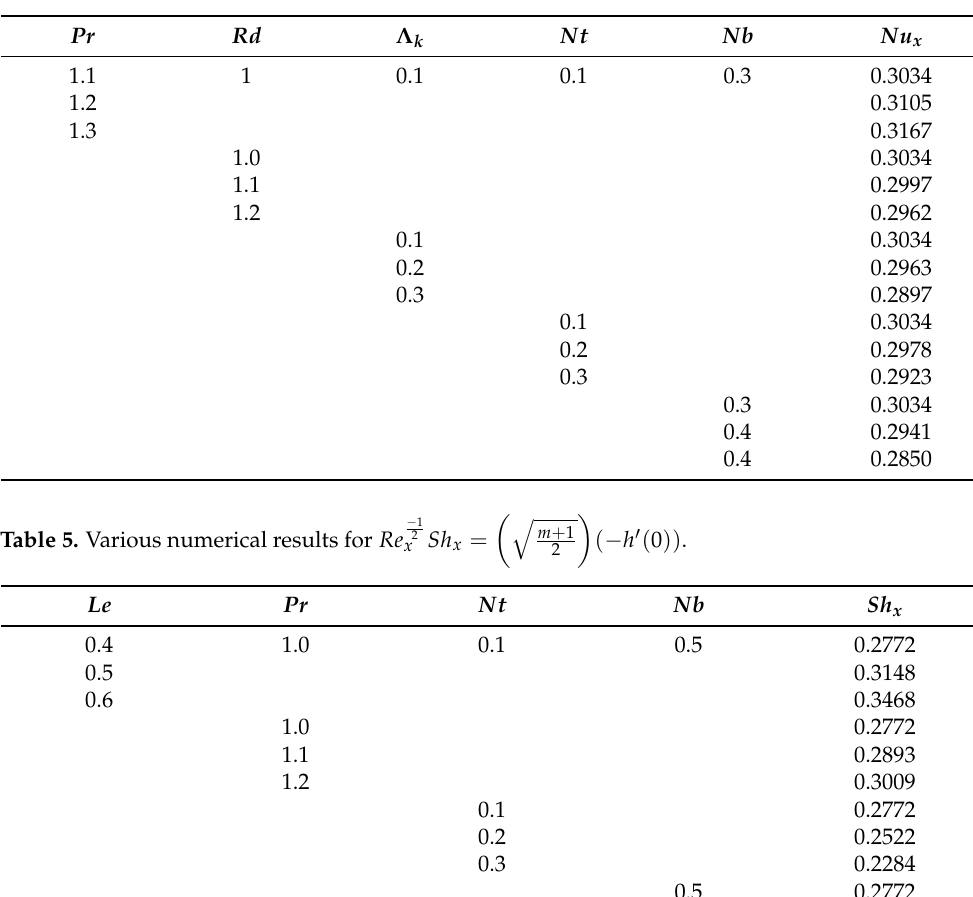
(cid:18)(cid:113) (cid:19) m + 1 ( Λ ( 0 ) + ( 1 + Rd ))( g (cid:48) ( 0 )) . k g 2